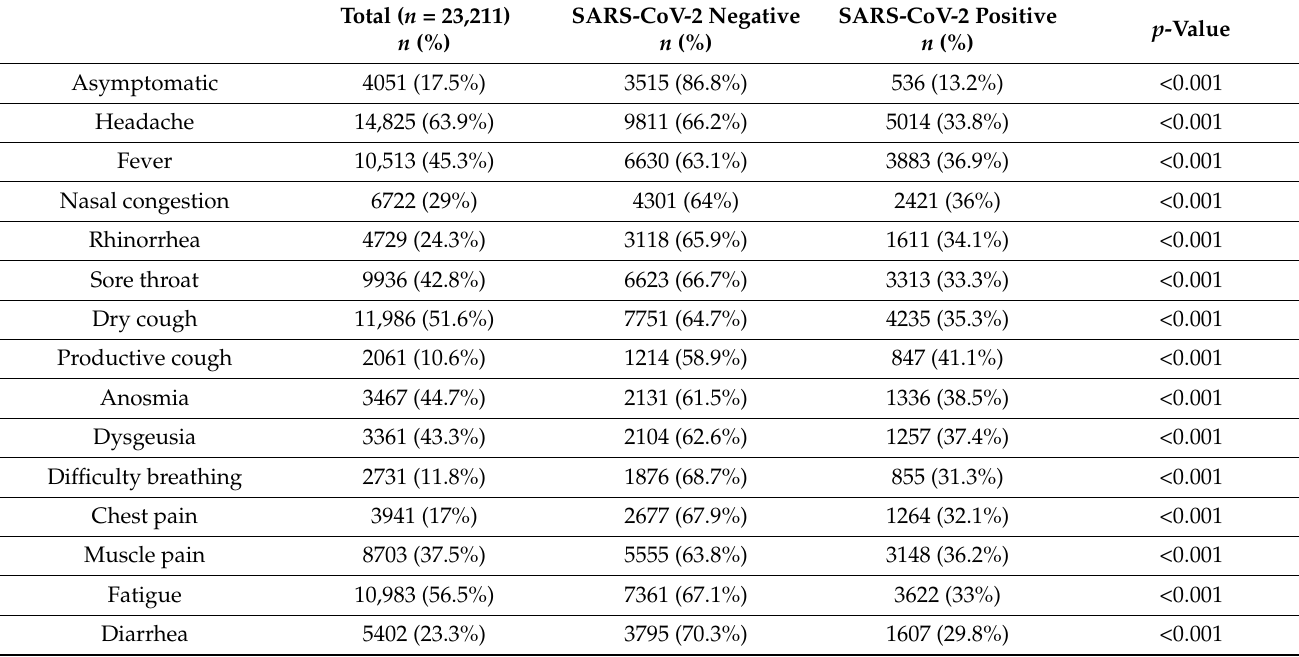
Table 2. Reported symptoms from people assisting to monitoring diagnosis center for molecular SARS-CoV-2 testing; all individual symptoms and lack of symptoms (asymptomatic) are included.